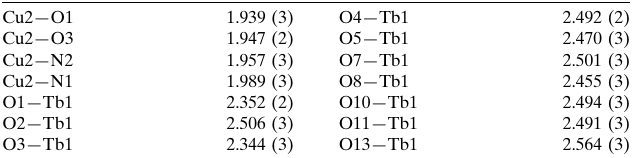
Selected bond lengths (A˚